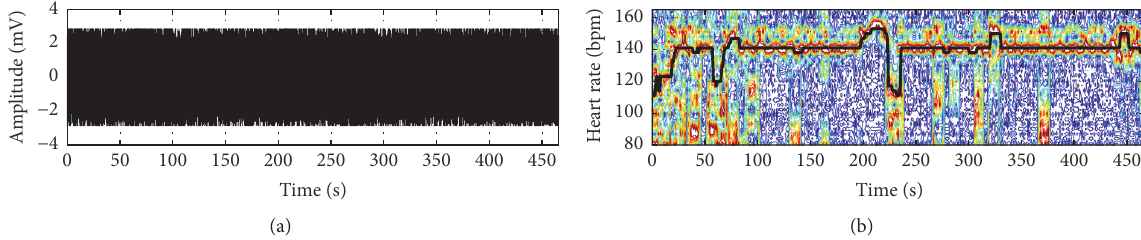
Figure 2: Time-varying fetal heart rate monitoring. (a) An fPCG signal with saturated noise. (b) Detected time-varying fetal heart rate.